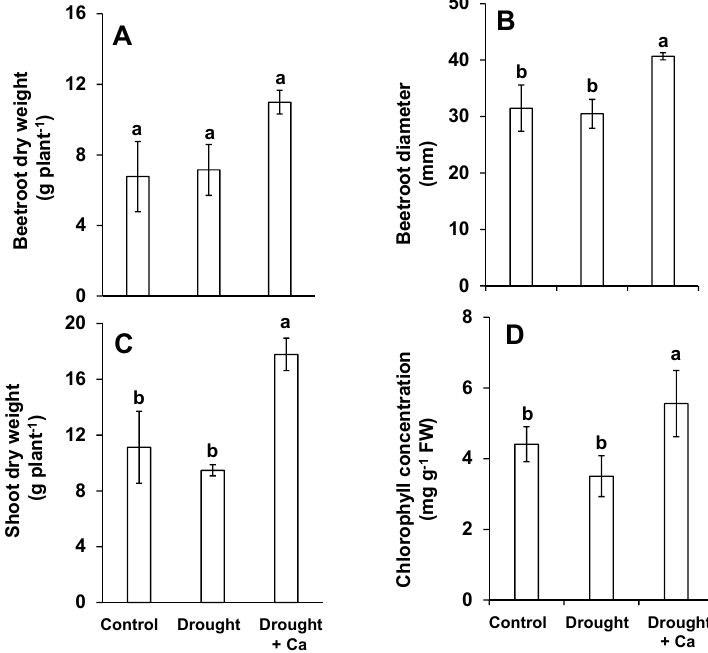
Figure 1. Influence of foliar application of Ca 2 + on sugar beet root and shoot biomass and chlorophyll concentration under drought stress. ( A ) Beetroot dry weight; ( B ) beetroot diameter; ( C ) shoot dry weight; ( D ) chlorophyll concentration. Plants were grown in pots for a duration of 8 weeks. Five-week-old sugar beet plants were kept at 90% field capacity as control or exposed to drought stress (30% field capacity) for a duration of 3 weeks. Ca 2+ was applied at BBCH14 and BBCH18 in concentration of 5 L ha − 1 corresponding to 540g Ca ha − 1 . Leaves and beetroot were harvested at 60 days after sowing for biomass and chlorophyll analysis. Bars indicate means ± SD. Different letters denote significant differences according to ANOVA followed by SNK test ( p < 0.05; n = 6).